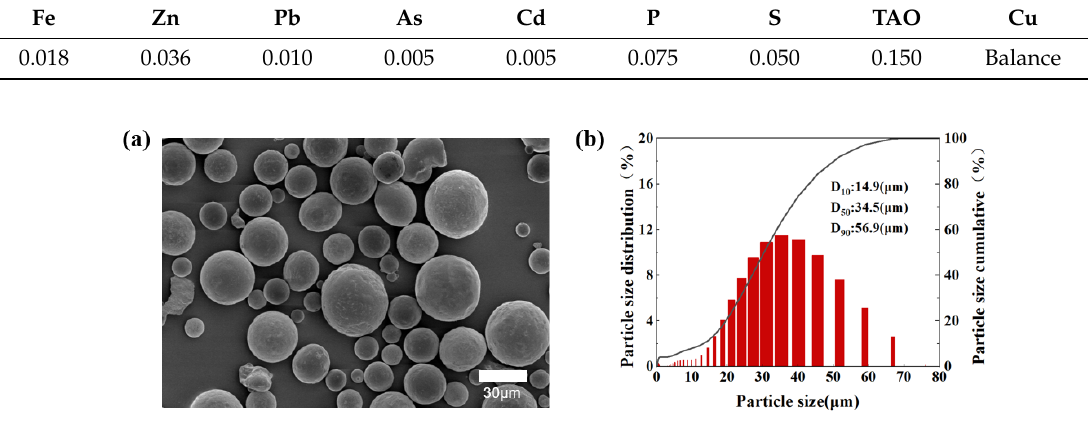
Figure 1. ( a ) Morphology of the pure copper powder detected using SEM. ( b ) Particle size distribution of the pure Cu powder.